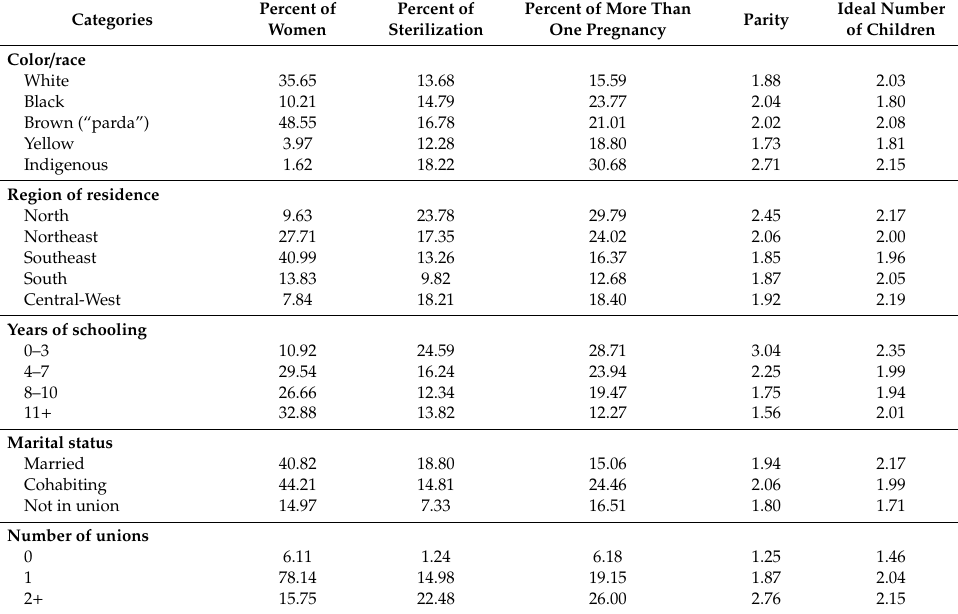
Table 3. Distribution of women by color / race, region of residence, years of schooling, marital status, and number of unions at the moment of interview, Brazil, January 2001 to July 2007. Percent of Percent of Percent of More Than Ideal Number Categories Parity Women Sterilization One Pregnancy of Children Color / race White